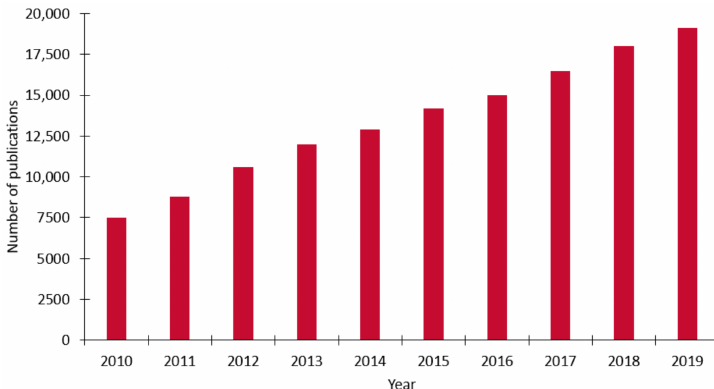
Figure 1. Number of publications per year found in the Google Scholar database using the search term “microbial fuel cells” (MFCs); (data acquired on 29 October 2020).